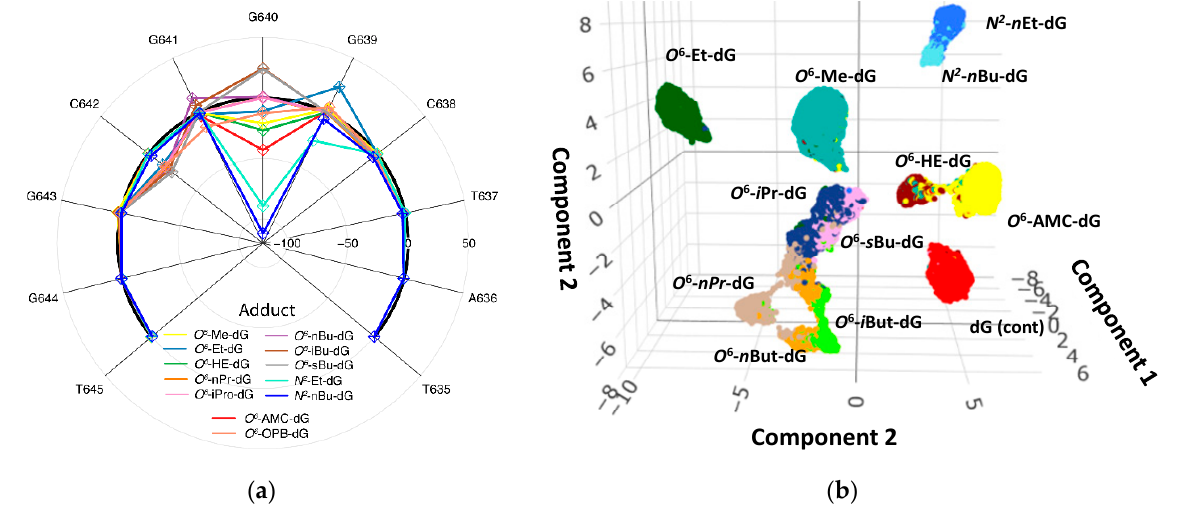
Figure 2. Characterization and separation of DNA adducts based on raw ONT signal: ( a ) radar plot displaying the disturbance in raw ONT signal of 12 DNA adducts at position G640, compared with dG-containing control plasmid.; ( b ) dimensional reduction analysis plot of the re-squiggle signals of ONT reads from 12 plasmids containing a site-specific DNA adduct or dG (red) at position G640. The separation is driven by the alkyl chain length and, to some extent, by the isomeric structures for the propyl- and butyl-adducts.